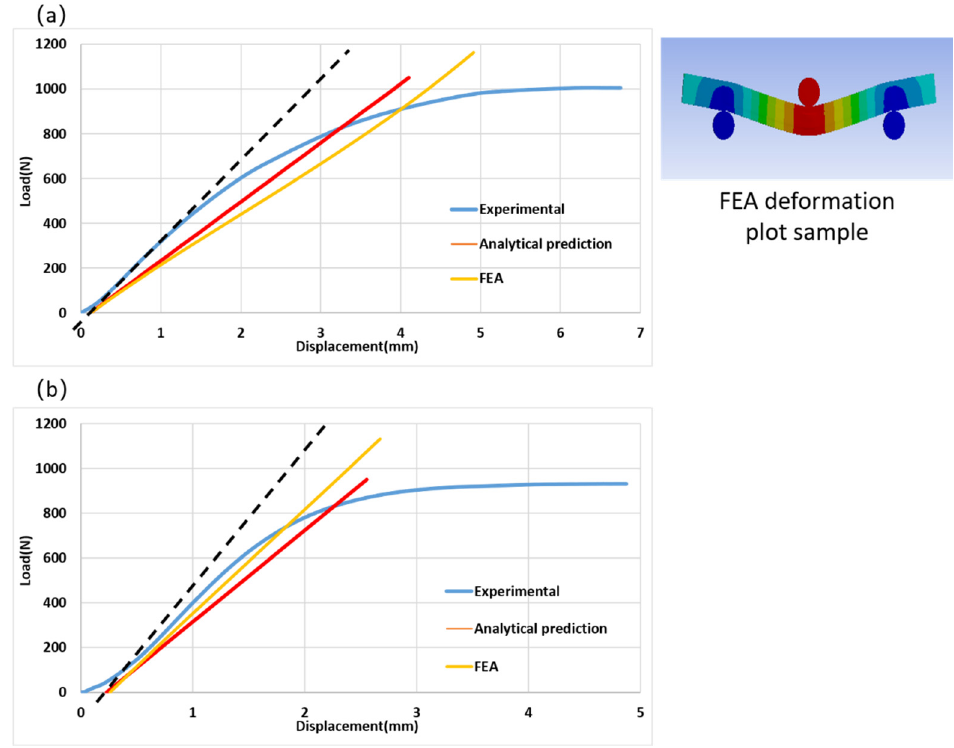
Figure 5. ( a ) Load versus displacement of sample 1 (RCF); ( b ) load versus displacement of sample 2 (mixed).